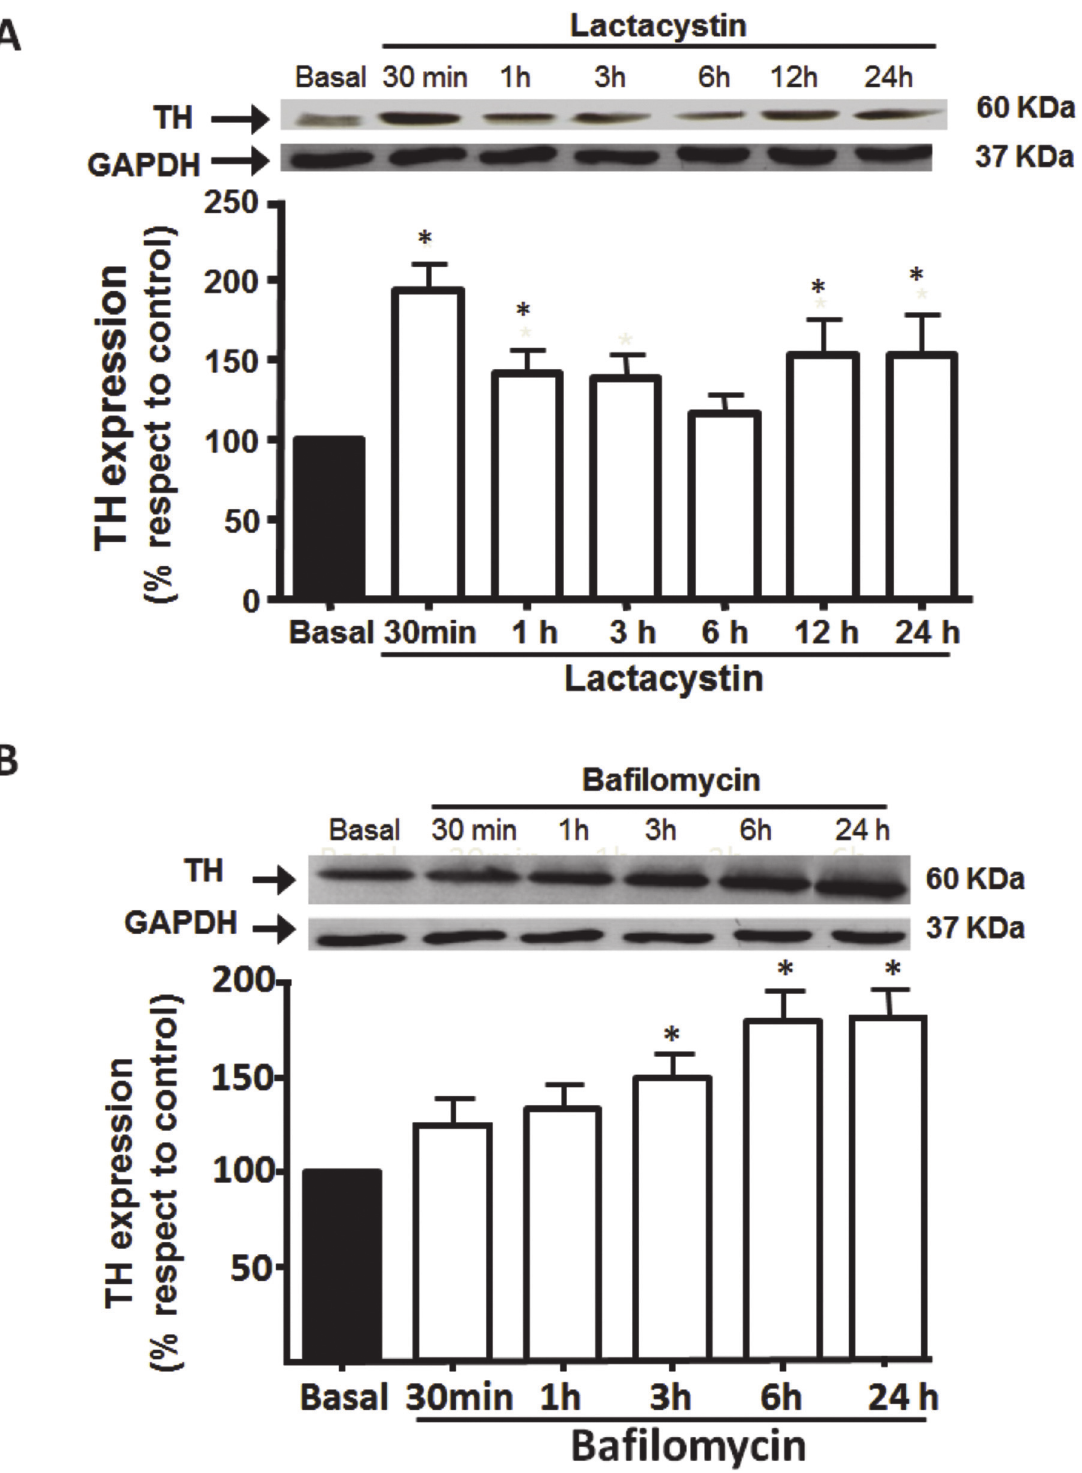
Fig 1. Effect of proteasome and lysosome inhibition on TH protein level. PC12 cells were treated with 1 μ mol/L lactacystin (A), a specific proteasome inhibitor, or 5 nmol/L bafilomycin (B), a H + -ATPase inhibitor, at different times and TH protein level assessed by Western-blot as described under Methods. The blots were stripped and reprobed for GAPDH to assess protein loading. Signals from TH protein level were normalized to GAPDH levels. Each bar represents the mean ± SEM of 3 determinations from four separate cell culture preparations. * P < 0.05 as compared to basal.